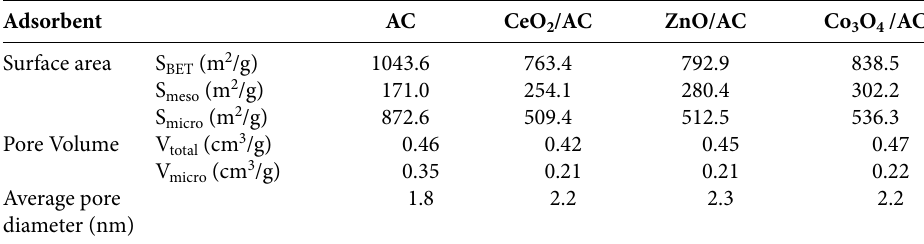
Table 3. The textural characteristics of the adsorbents.